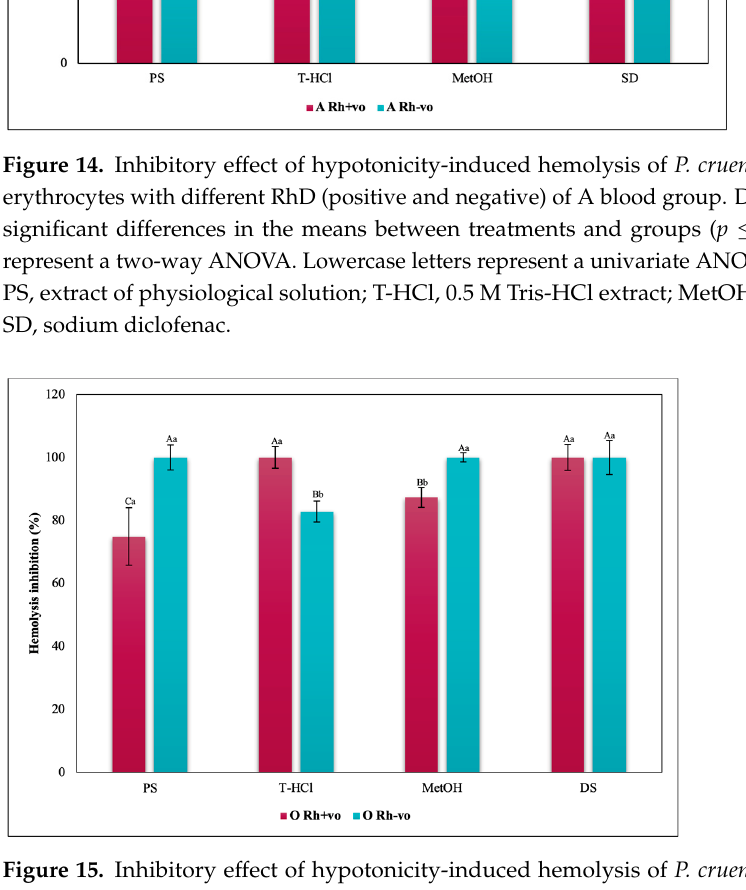
Figure 16. Inhibitory effect of hypotonicity-induced hemolysis of P. cruentum extracts on human erythrocytes with different RhD (positive and negative) of AB blood group. Different letters repre- sent significant differences in the means between treatments and groups ( p ≤ 0.001). Capital letters represent a two-way ANOVA. Lowercase letters represent a univariate ANOVA between the ex- tracts. PS, extract of physiological solution; T-HCl, 0.5 M Tris-HCl extract; MetOH, 99% methanol extract; SD, sodium diclofenac. The evaluation of the influence of RhD on the antihemolytic capacity of the extracts indicates that the aqueous extracts had a greater erythroprotective effect in the A Rh+ve group compared to the A Rh-ve group (Figure 14). Likewise, the MetOH extract generated the greatest erythroprotective effect in the O Rh+ve group and that of T-HCl in the O-, both equivalent to that of FXA (Figure 15). In the case of the AB Rh+ve group, the MetOH extract performed a greater antihemolytic function than the aqueous extracts, equivalent to that of the standard antioxidants, with more favorable results in the AB Rh+ve group (Figure 16). The stability of the erythrocyte membrane can be extrapolated to the stabilization of the lysosomal membrane, due to its absence of organelles and similarity to the cell mem- brane [104]. During the inflammatory process, leukocytes and neutrophils release lysoso- mal enzymes towards the inflammation sites [105,106], and these can generate persistent